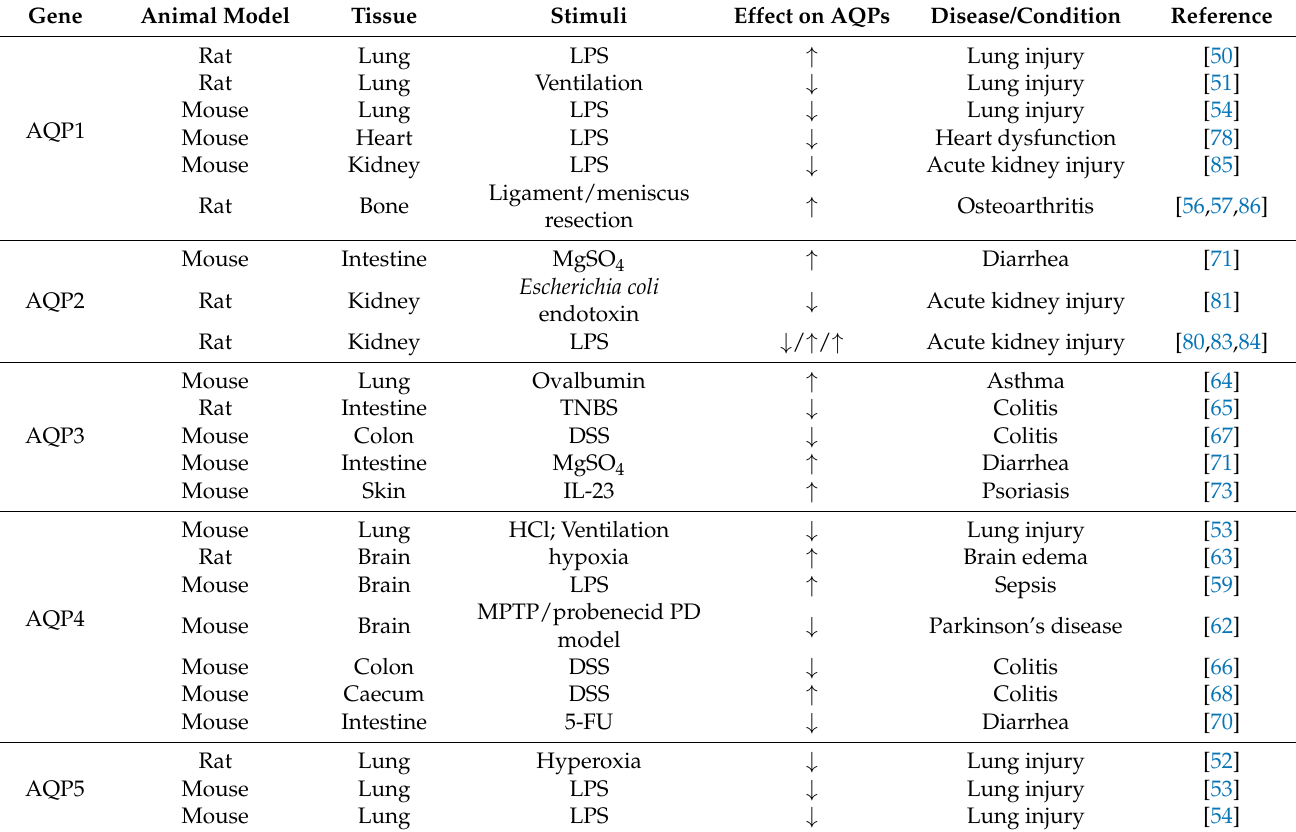
Table 2. AQPs’ involvement in inflammatory